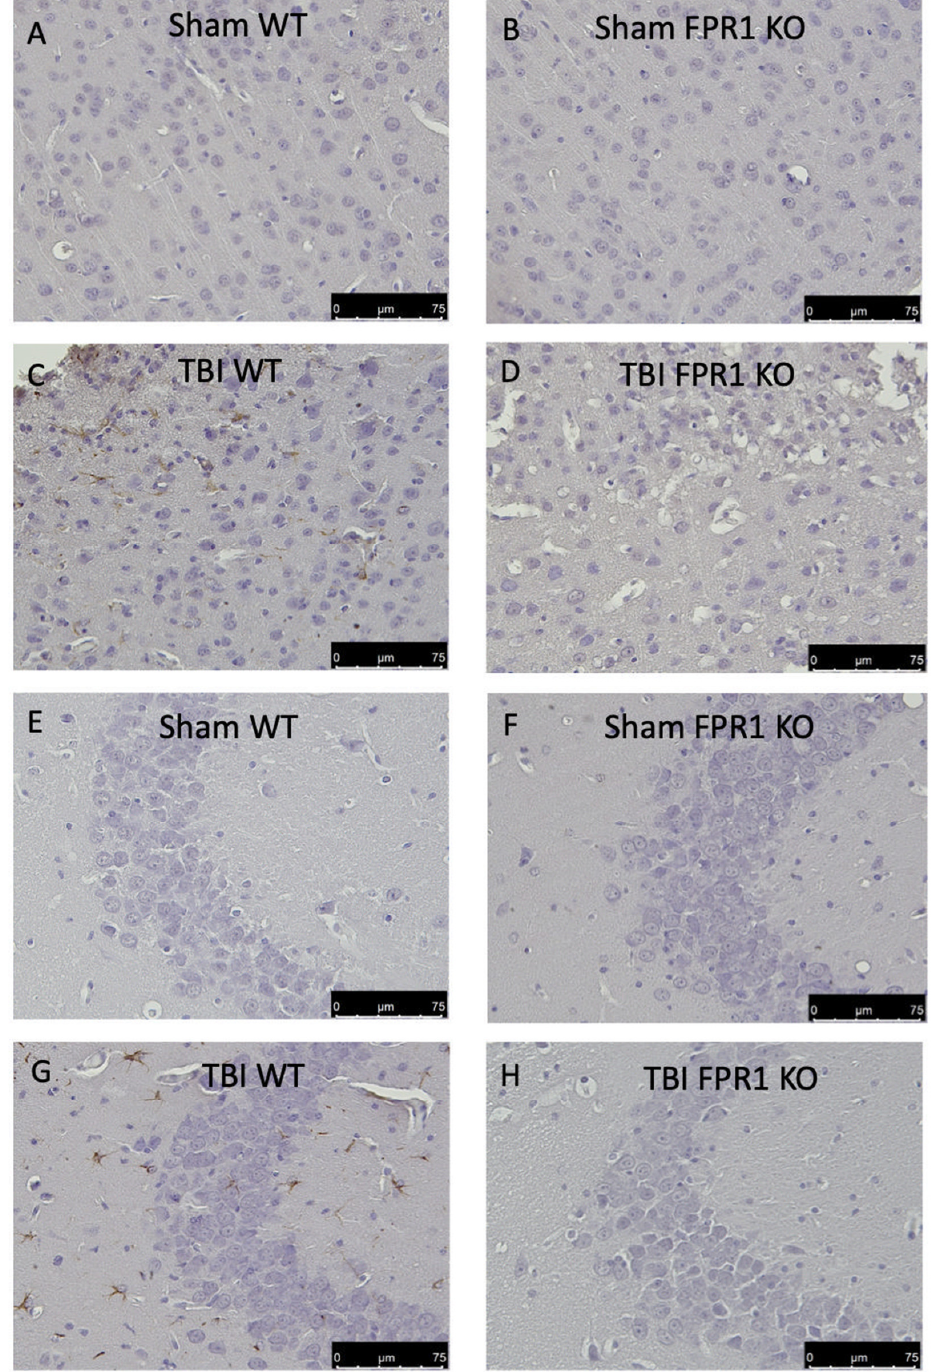
Figure 8. Effect of the absence of Fpr1 on astrocytes: Immunohistochemical analysis shows an upregulation of GFAP expression in the cortex ( C ) and hippocampus ( G ) in the TBI WT group 24 h after injury, compared to the Sham WT cortex ( A ) and hippocampus ( E ) and Sham Fpr1 KO cortex ( B ) and hippocampus ( F ) Fpr1 KO animals 24 h after TBI show reduced expression of GFAP-positive cells in both the cortex ( D ) and hippocampus ( H ) For immunohistochemical staining, a 40 × magnification is shown (75- µ m scale bar). For the analyses, n = 5 animals from each group were employed. Results were analyzed by two-way ANOVA followed by a Bonferroni post-hoc test for multiple comparisons. Non-parametric data were analyzed with Fisher’s exact test.